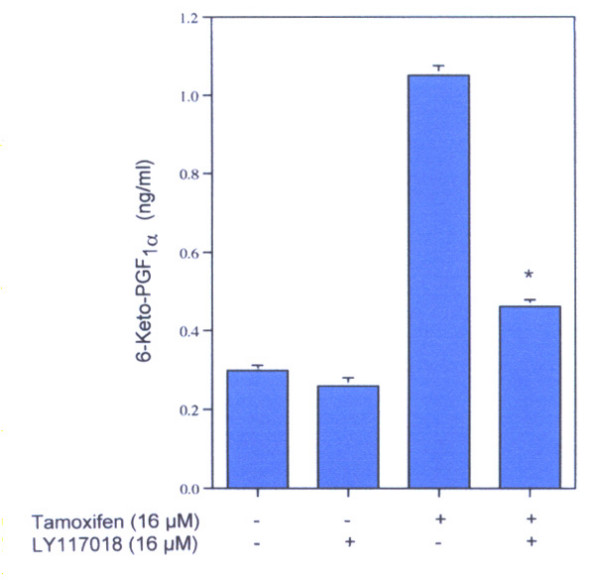
Effect of tamoxifen, LY117018 and tamoxifen plus LY118018 (all at 16 μM), on 6-keto-PGF1α production. The rat liver cells were incubated 6-h. The analyses were performed with quintuplicate dishes. Each bar gives the mean value and the brackets the SEM. * Statistically significant vs tamoxifen.